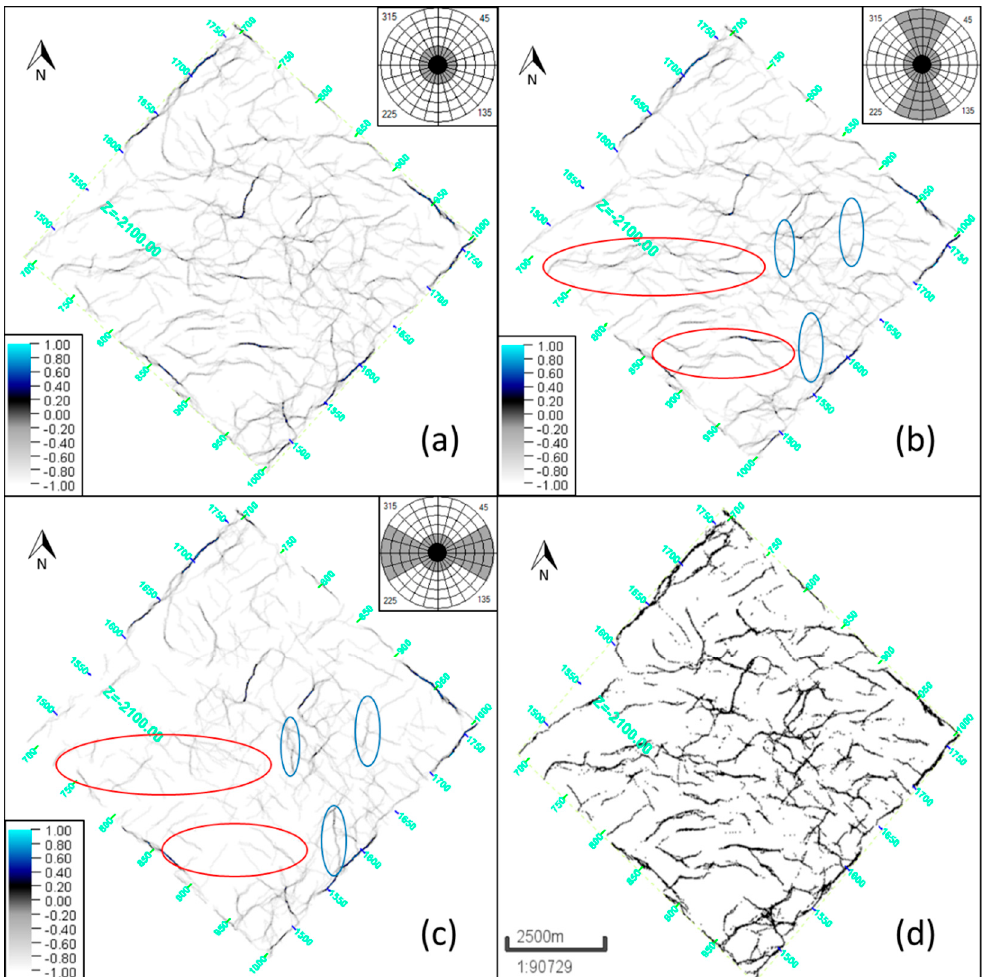
Figure 5. A time slice showing the ant tracking attribute. The results of ant tracking without azimuthal filter ( a ); ant tracking using a N–S filter ( b ); ant tracking using a W–E filter ( c ); the ant tracking result was merged with the ant tracking results extracted using different azimuthal filters ( d ). The red ellipses indicate the detected W–E discontinuities (appear in Figure 5b) that did not disappear in Figure 5c; the blue ellipses indicate the detected N–S discontinuities (appear in Figure 5c) that were not disappeared in Figure